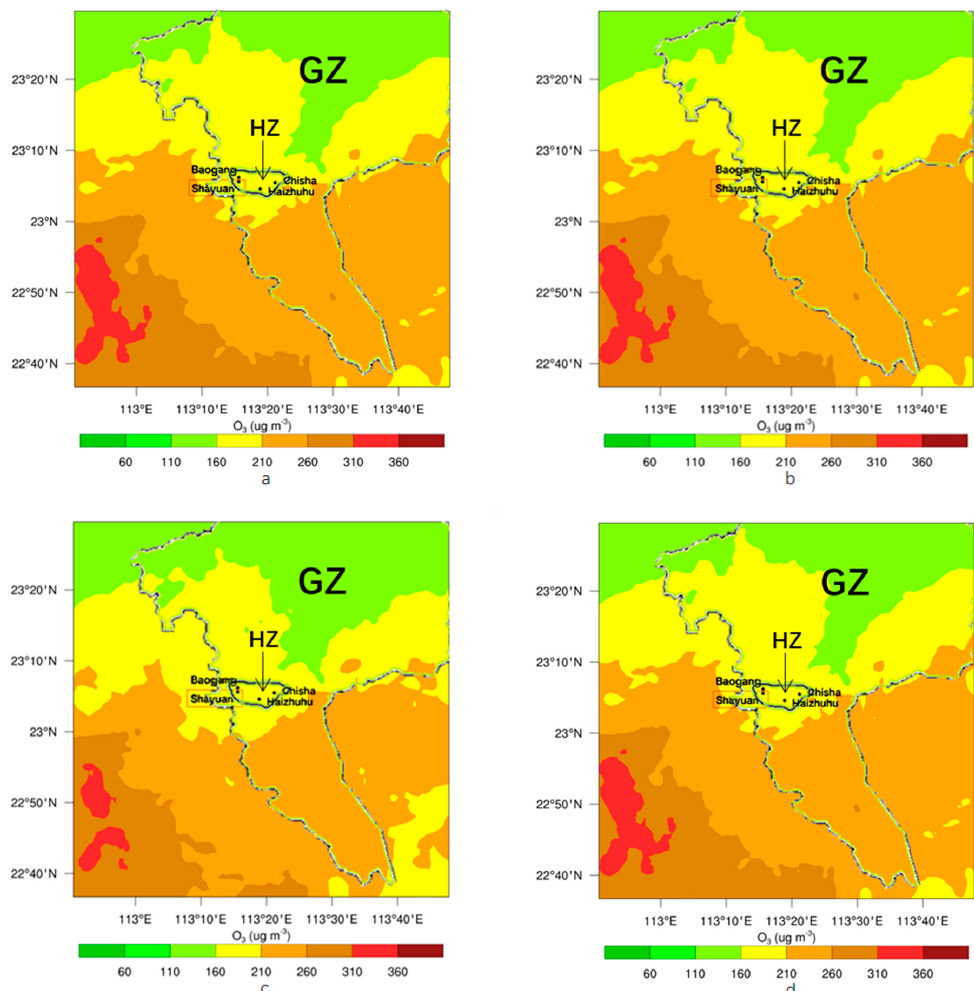
Figure 9. Maps of the simulated O 3 mean daily 8 h maximum concentration distribution over